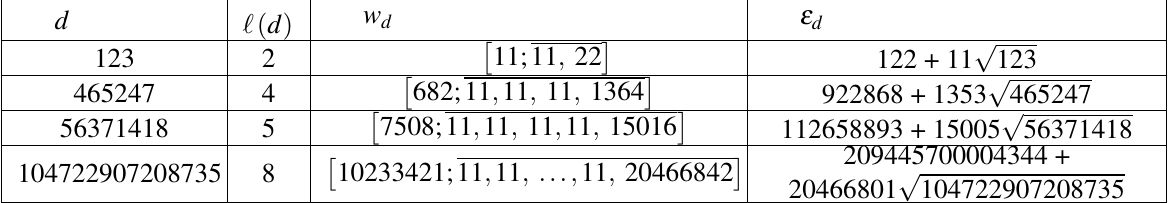
Table 1 Numerical Results for Corollary